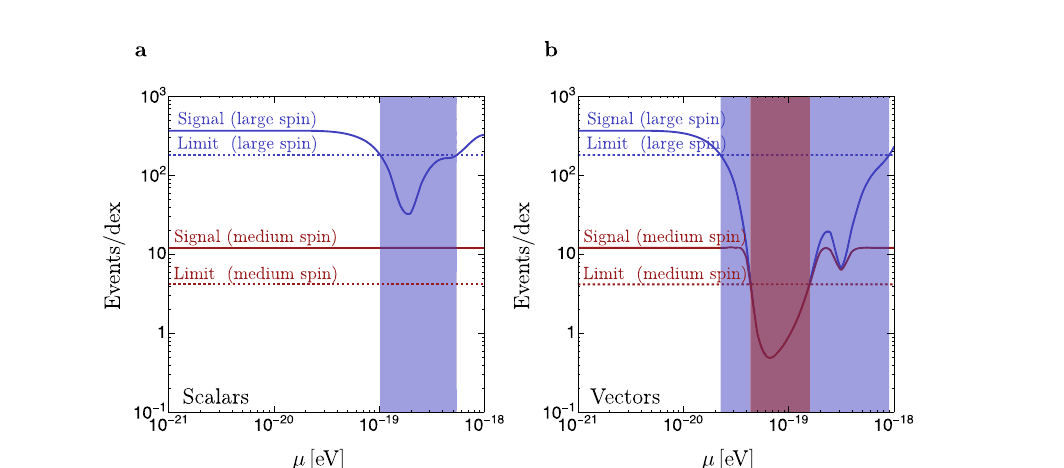
Fig.5|Projectedlimitsonscalarsandvectors. Solidblueandredlines:numberof TDE events expected to be observed by the Vera Rubin's LSST in the mass bin 8 ≤ log M BH = M (cid:1) ≤ 9 forSMBHsthathavebeenspundownbyULBs,asafunctionof the ULB mass μ , for scalars ( a ) and vectors ( b ). The number of events is obtained under two assumptions for the unknown maximal spins that SMBHs can attain. In the “ largespin'' scenario (blue),weconsider SMBHswith themaximalspinallowed by thin-disk spin-up ( a =0.998) and superradiant spin-down. In the “ medium-spin'' scenario(red)wetakethespinstobethemaximalallowedbyaspinlimitof a =0.6